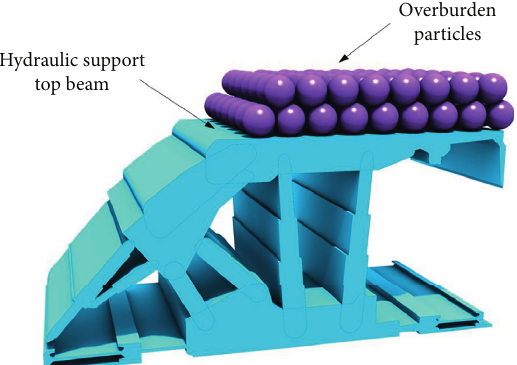
Figure 13: Hydraulic support and the overburden particles.